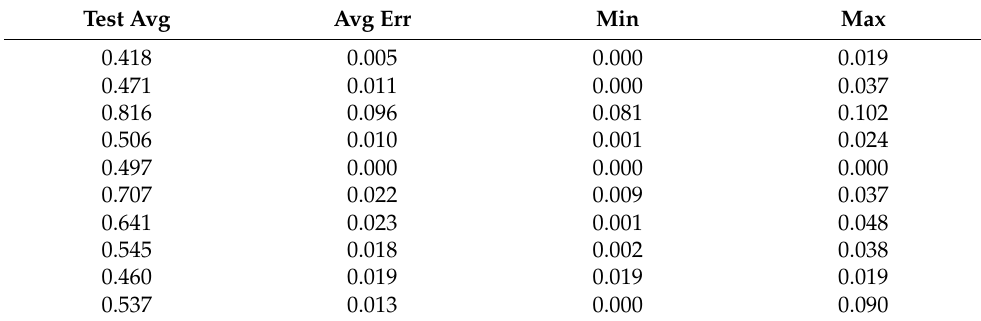
Table A221. Set 3, trials 41–50 data (single 0.5 PR value).